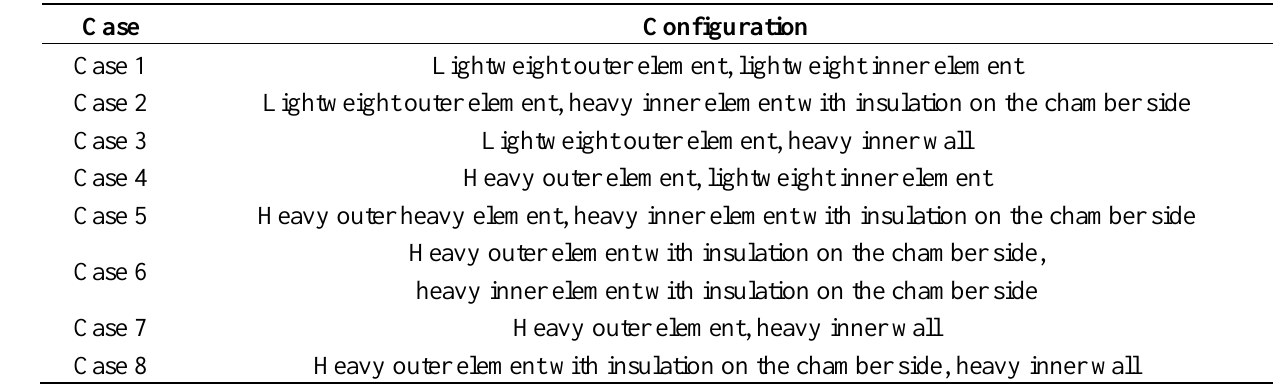
Table 2. Façade configurations.